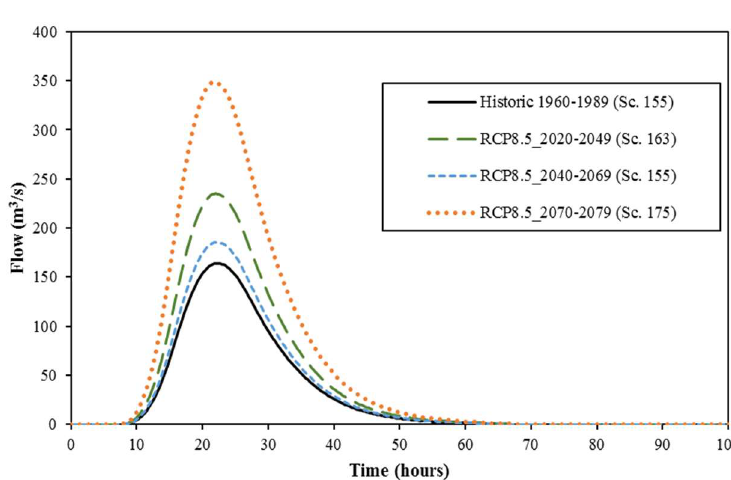
Figure 18. Hydrographs for the worst-case scenario (where Sc refers to the scenario number).